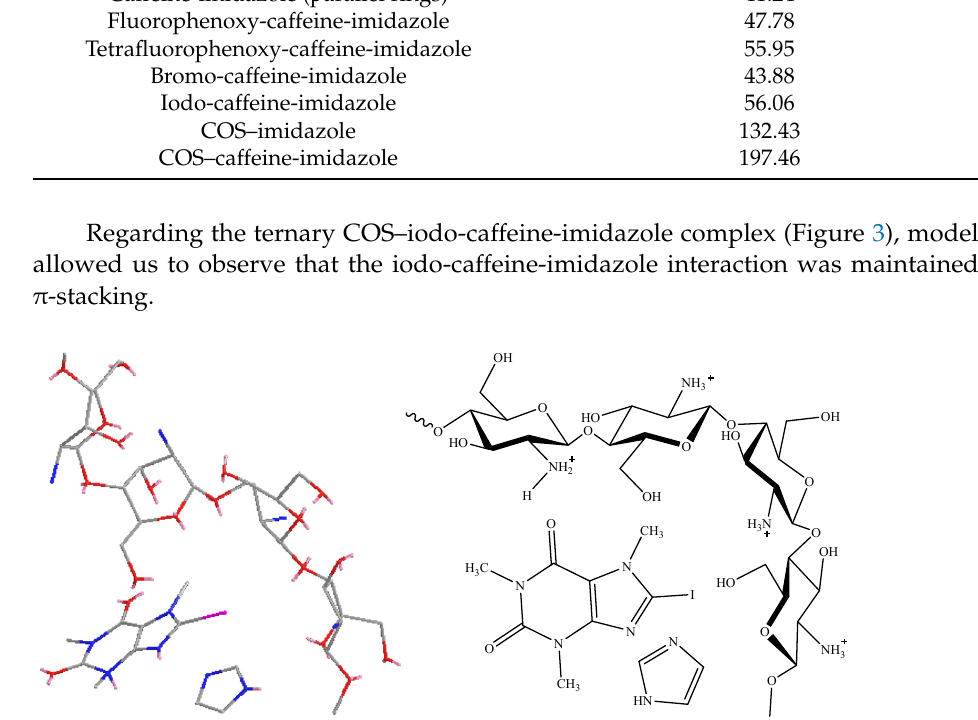
Table 4. Energy content of the conjugates of caffeine and its derivatives (fluorophenoxy-caffeine, tetrafluorophenoxy-caffeine, bromo-caffeine, and iodo-caffeine) with imidazole, chitosan oligomers (COS) with imidazole, and the COS–caffeine-imidazole complex.